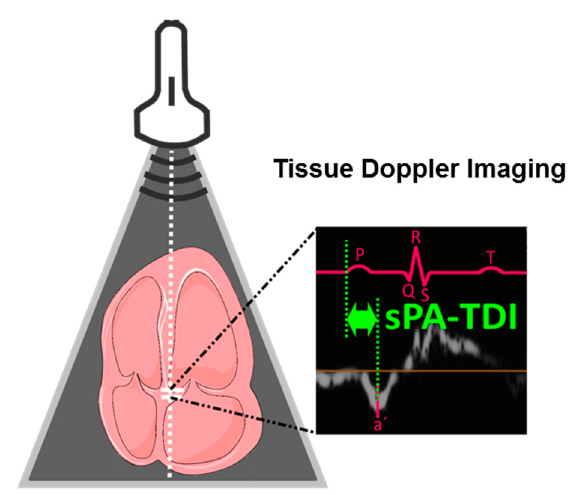
Figure 1. Determination of septal PA-TDI (sPA-TDI). Septal PA-TDI was determined in tissue Doppler imaging and defined as interval between the onset of P-wave in lead II of the electrocardiogram (ECG) and the peak a`-wave of the septal mitral valve annulus.